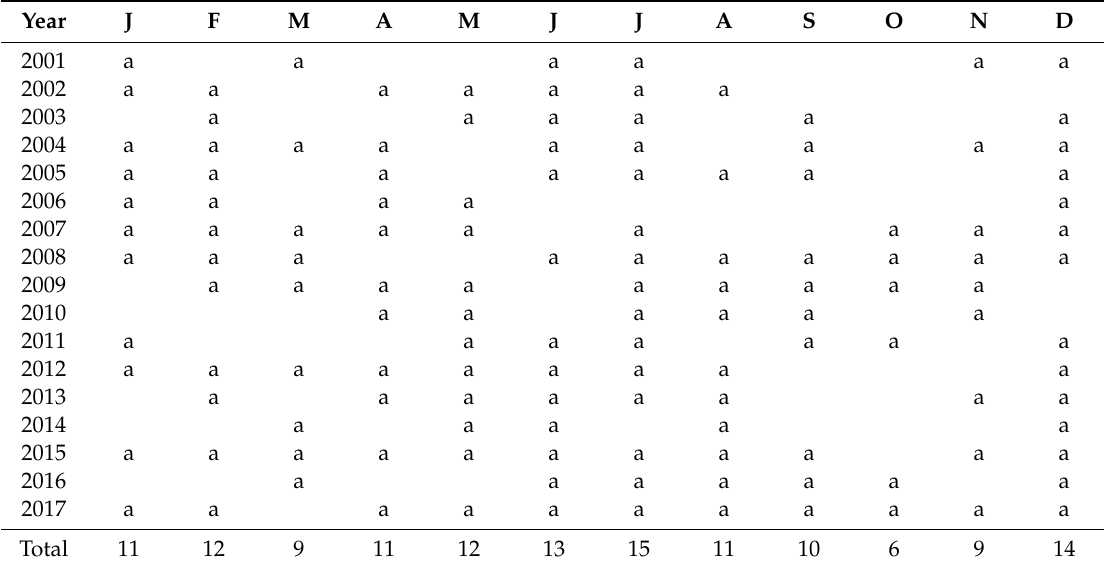
Figure 4. Trend lines. As can be seen in the figures, the lines indicate an increasing tendency for anomalies to occur, allowing it to be inferred that, over the years, an increasing number of anomalies can be expected to occur. Table 7. Distribution of climatic anomalies by the months of the years of the period under